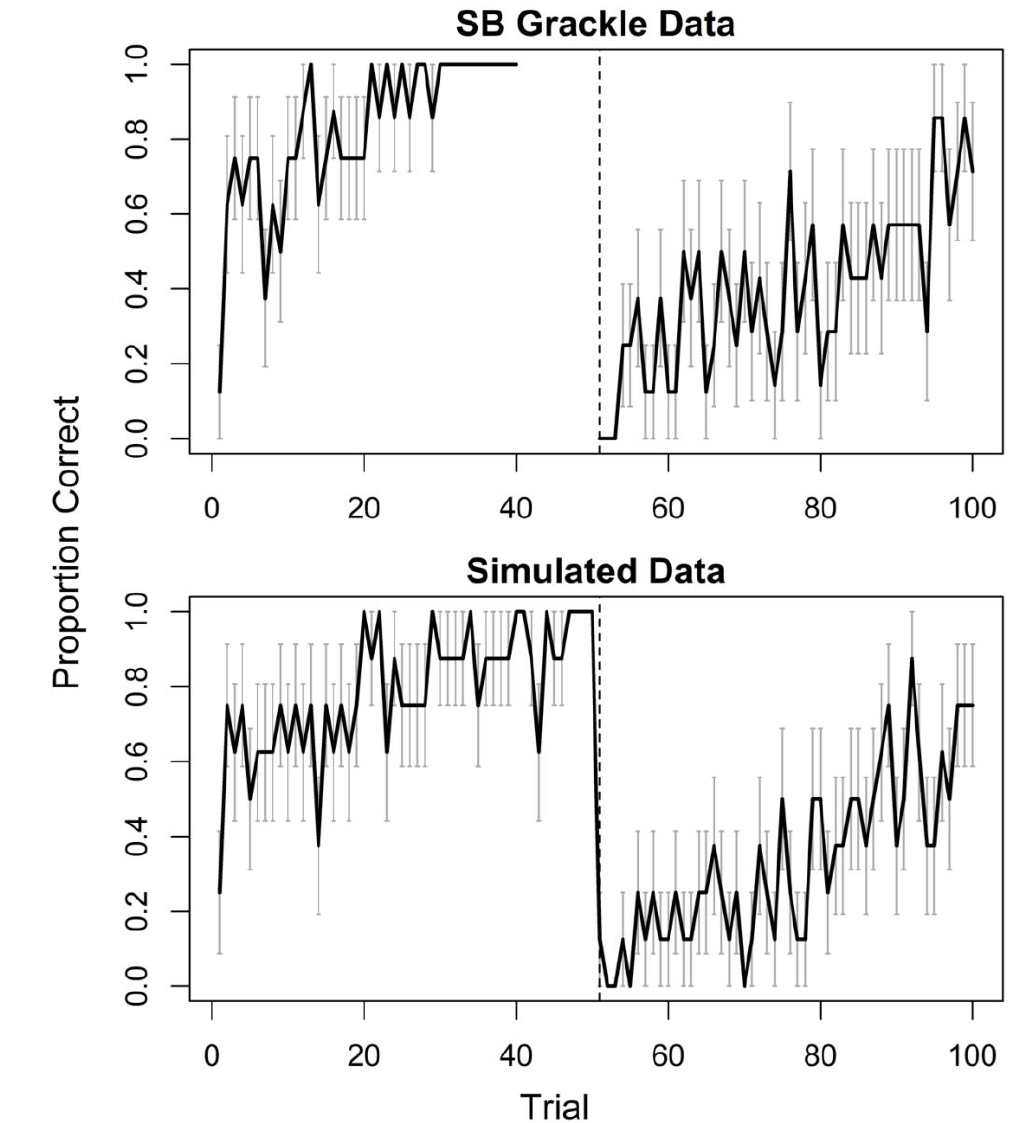
Figure 4. Mean proportion of correct choices (black lines) per trial in a reversal learning experiment for Santa Barbara, California great- tailed grackles (N = 8; top), and “birds” simulated from the reinforcement learning model using parameter estimates (N = 8; bottom). Dashed vertical lines indicate color reversal. Gray error bars show standard errors of the mean Figure 5 plots posterior predictions for the effect of individual-level learning rate 𝜙𝑗 on causal score for three different levels of the random choice rate 𝜆𝑗 (results are presented as posterior means and 89% highest posterior density intervals (HPDI)). We did not find robust associations between either learning rate ( 𝛽𝜙 = 0.03, HPDI = -0.63 - 0.69) or random choice rate ( 𝛽𝜆 = -0.40, HPDI = -0.96 - 0.25) and birds’